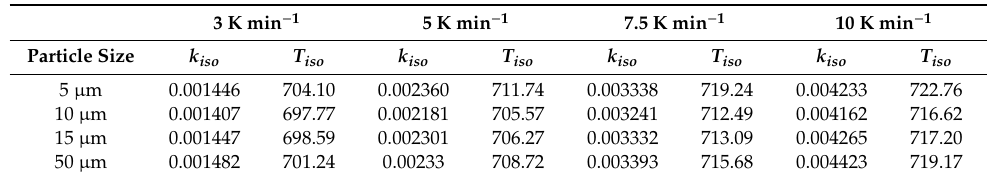
Table 4. The values of k iso and T iso by model fitting methods for pyrolysis of polystyrene particles with four sizes. 3 K min − 1